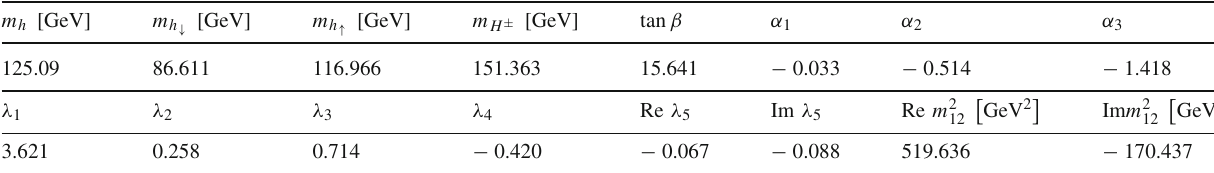
Table 4 Input parameters of the benchmark point BMPI discussed in Sect. 4.5: the parameter point is defined for the C2HDM TI